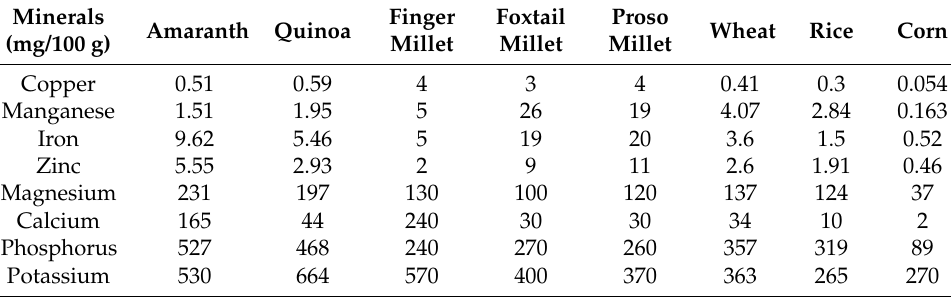
Table 3. Mineral content of ancient and common